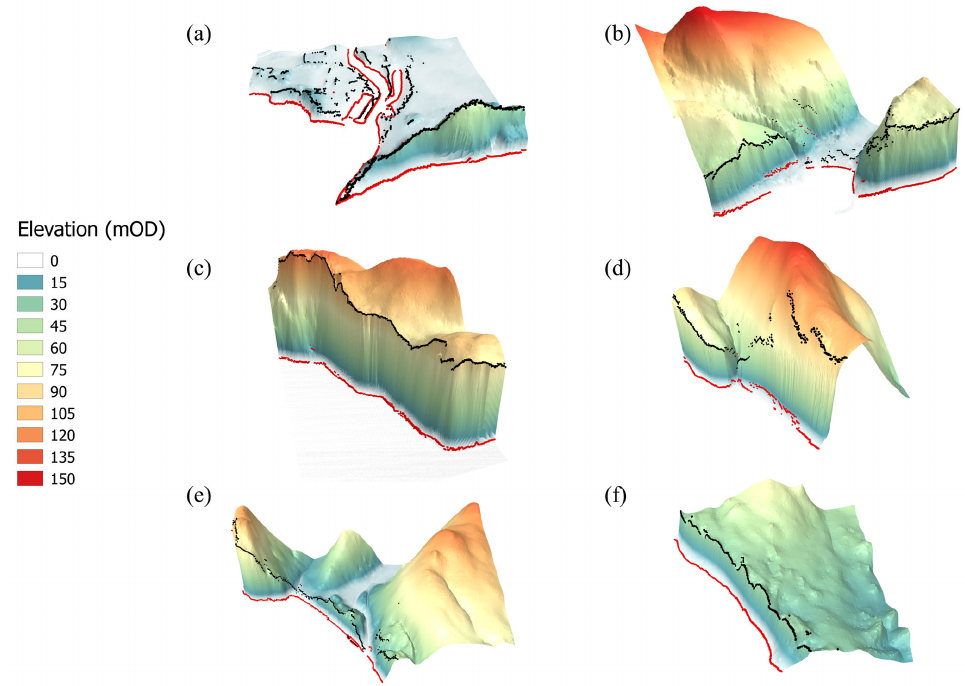
Figure 9. 3-D models of different coastal morphology environments with the cliff toe (black spheres) and cliff top (red spheres) delineated using the 5m DEM and 61-point smoothing: (a) estuarine, (b) bay with harbour, (c) high-cliffed coastline, (d) pocket beach, (e) beach at the seafront of a relic valley and (f) low-cliffed coastline (eroding moraines).